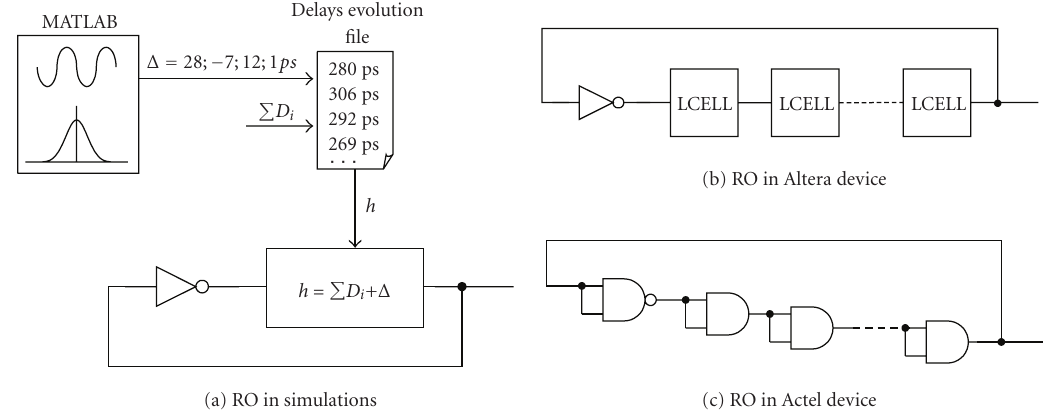
Figure 3: Implementation of ring oscillators in simulations and in